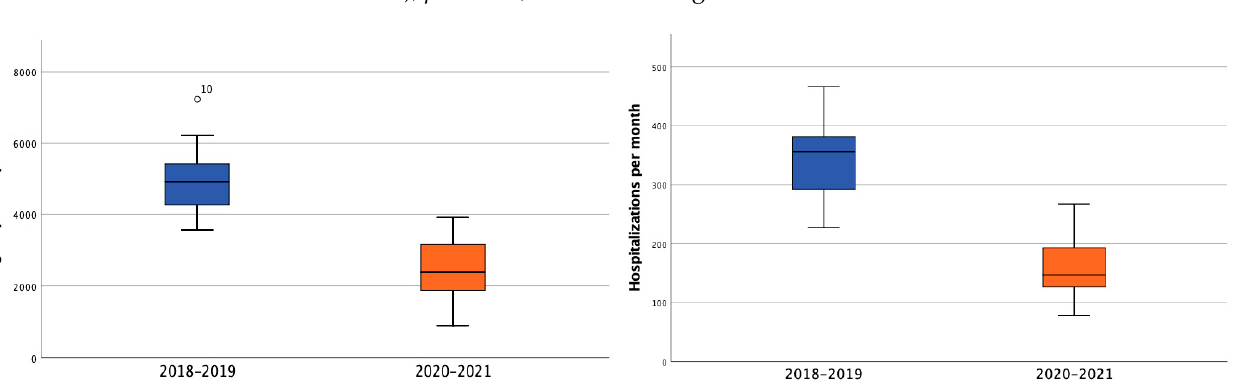
Figure 6. Comparison of pediatric emergency visits and hospitalizations per month during the periods 2018–2019 (blue) and 2020–2021 (orange).